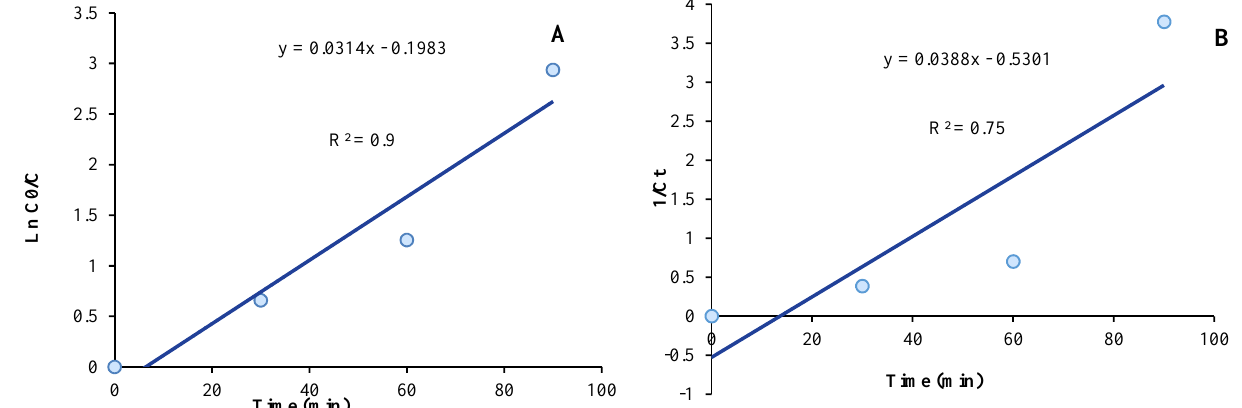
Figure 10. Phenol removal kinetics in the UV/ZnO process: (A) the pseudo-first-order and (B) the pseudo- second-order (pH = 3, retention time = 90 minutes, and phenol concentration = 5 mg/l)